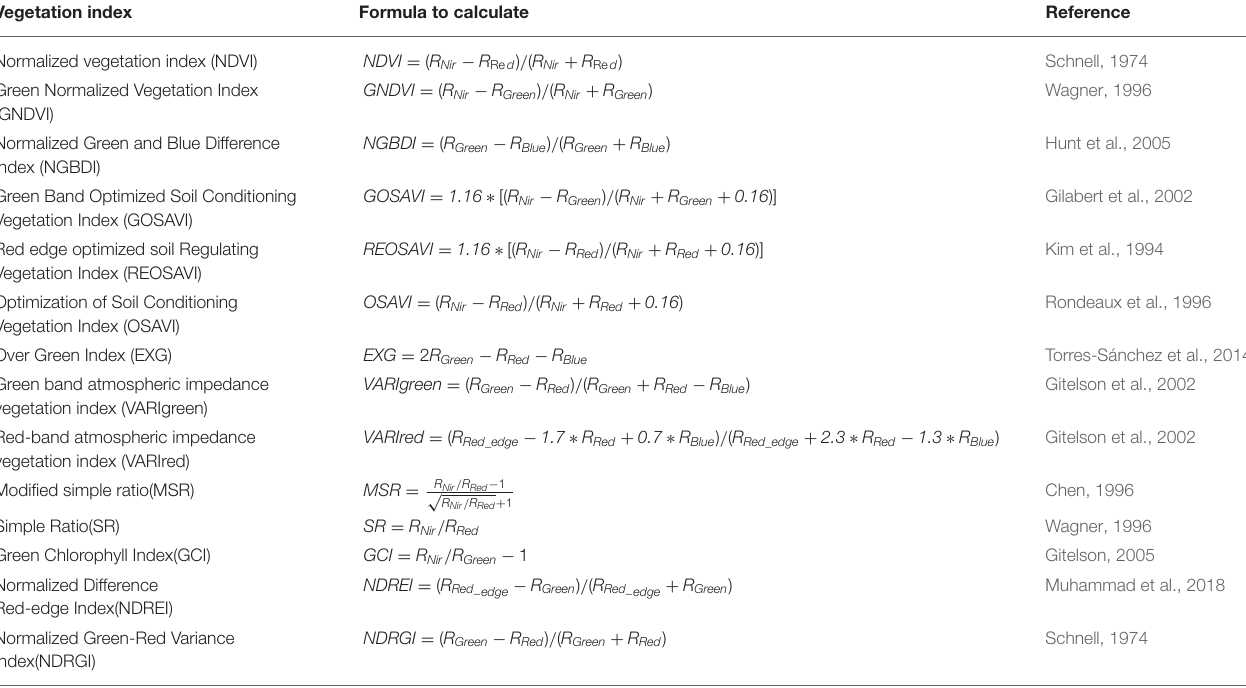
TABLE 3 | Vegetation index and its calculation formula. Vegetation